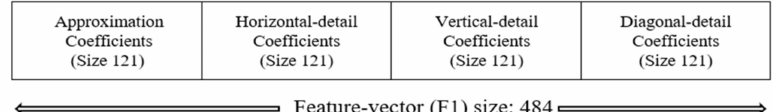
Figure 4. The frame format of features received from